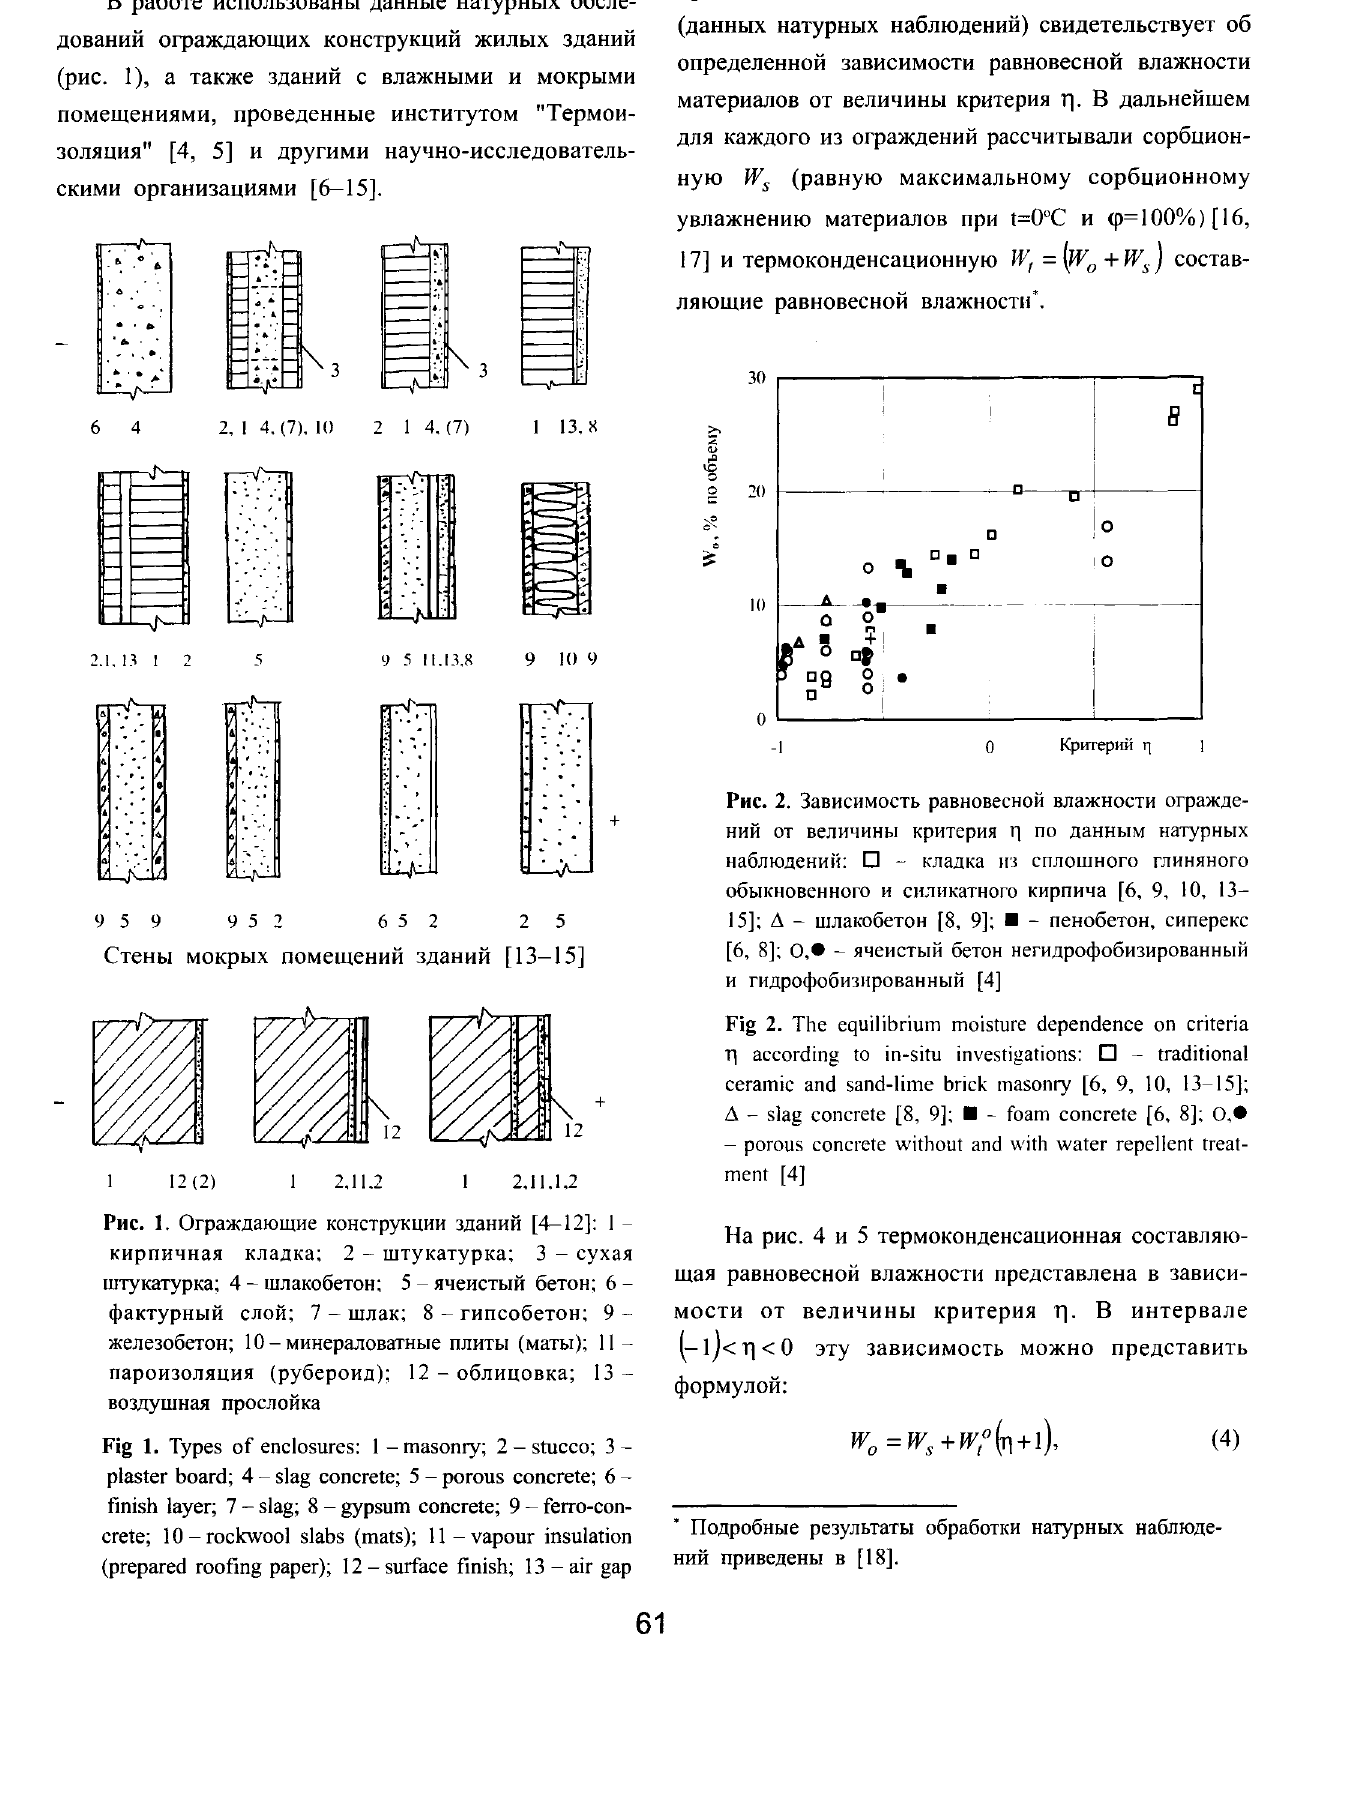
3. HcCJie.a:osauue pauuosecuoii BJia~uocTu orpiDK,lle uuii nO HaTypHbiM HafiJIIO.ll:CHHHM 3.1. MeTO.ll:HKa ucCJie.a:osauuii B pa6oTe ucnonbJOBaHbi .naHHbie HarypHbiX o6cne .nosaHuii orpa)J(,l.laiOIIIUX KOHCTpYKIIUH )J(UllbiX 3,l.laHUH (puc. 1 ), a TaK:IKe 3,l.laHUH C B.!la)J(HbiMU U MOKpbiMH IIOMeiiieHUHMU, npoBe,l.leHHbie UHCTUTyTOM "TepMOH- 30llHUUH11 [4, 5] u .npymMu Hay•mo-uccne.nosaTenb